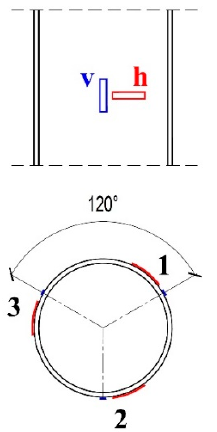
Figure 6. Arrangement of strain gauges to be applied to pipe: v—vertical, h—horizontal.